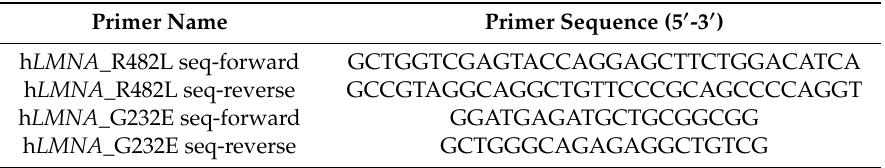
Table 2. Primers for sequencing analysis of